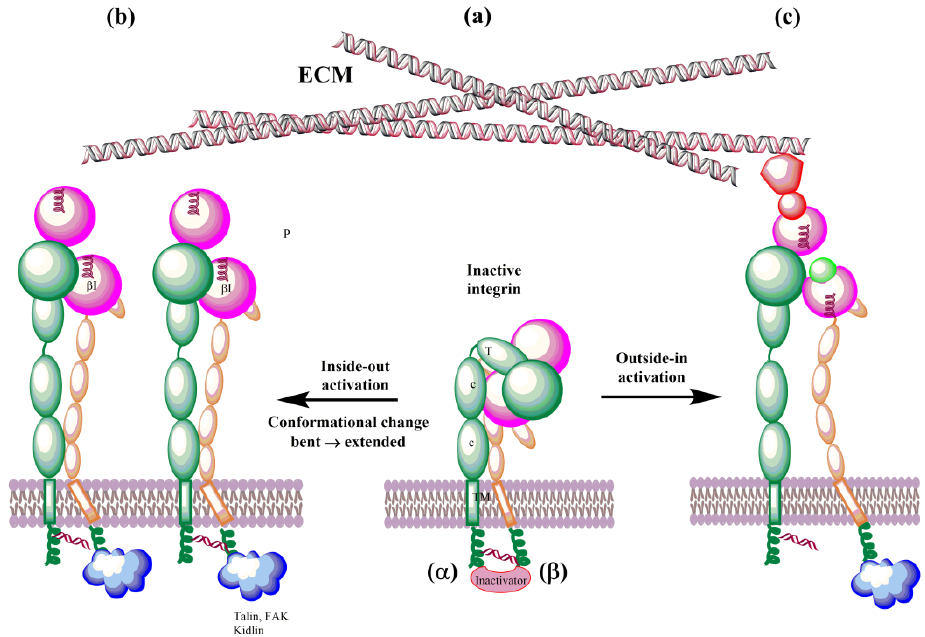
Figure 8. Schematic representation of bidirectional integrin activation. ( a ) Inactive integrin; ( b ) inside-out activation triggered by binding ligands to the cytoplasmic tail of β subunit; and ( c ) outside-in activation by interactions with ECM.